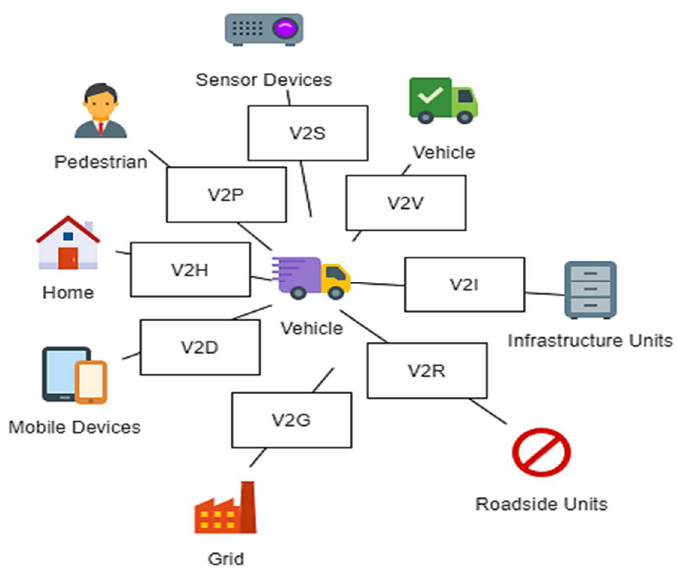
Figure 1. Communication models in IoV.